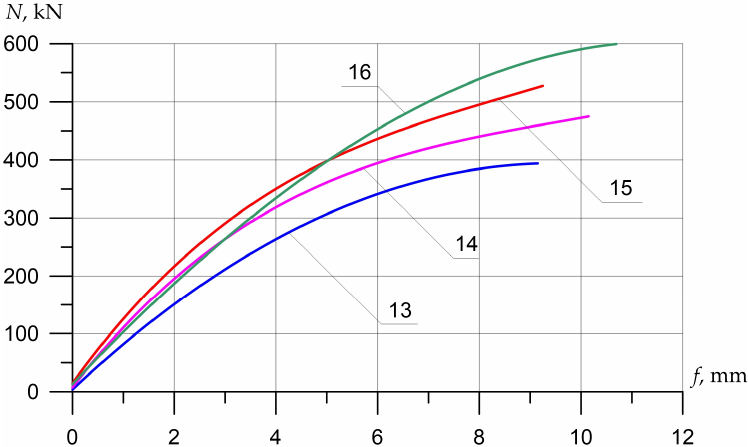
Figure 14. Comparison of experimental values of column deflections ( λ h = 10) depending on the magnitude of the load and variants for composite reinforcement with axial eccentricity e 0 = 4.0 cm (0.32 h). The numbers on the graphs correspond to the column numbers in Table 4.